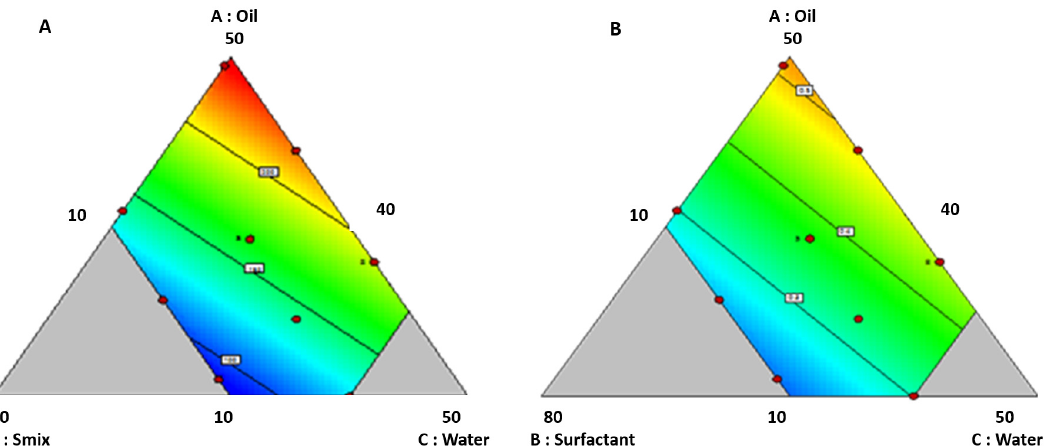
Figure 3. ( A ) Contour plots displaying the effect of variables on size; ( B ) contour plots displaying the effect of variables